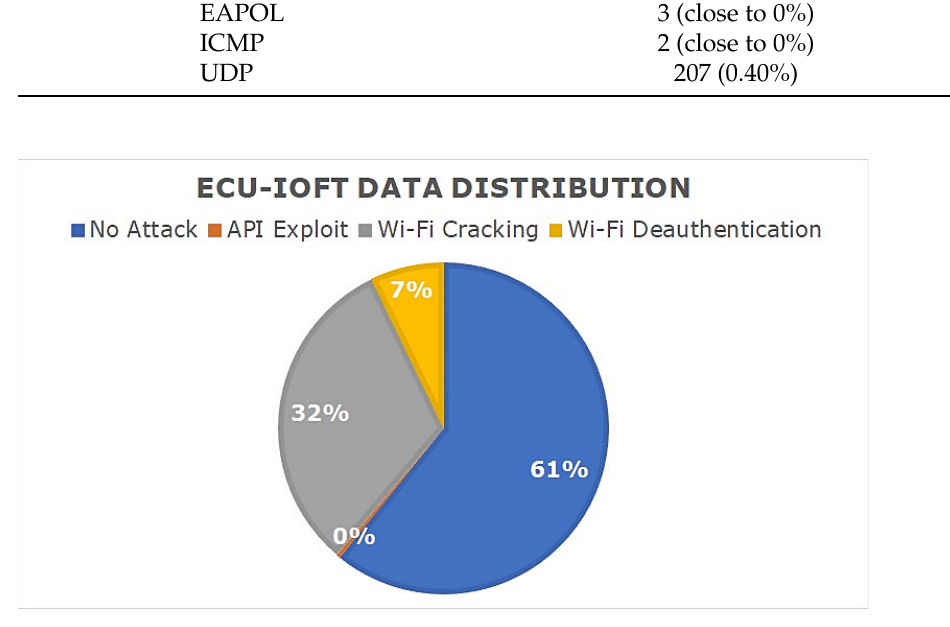
Figure 5. ECU-IoFT data